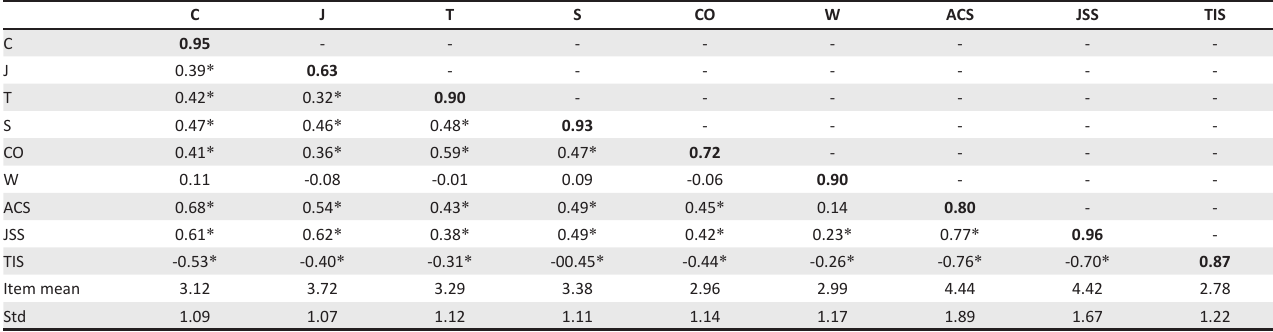
TABLE 4: Inter-correlation matrix of all variables included in the structural equation path model (EwC-on-Crt).